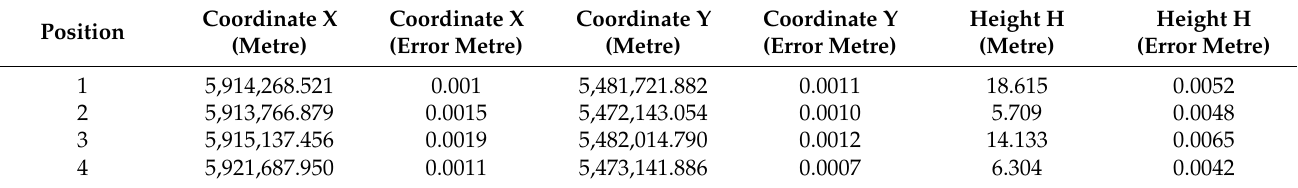
Table 3. Coordinates aligned with ASG-EUPOS stations of 3 h measurements (November